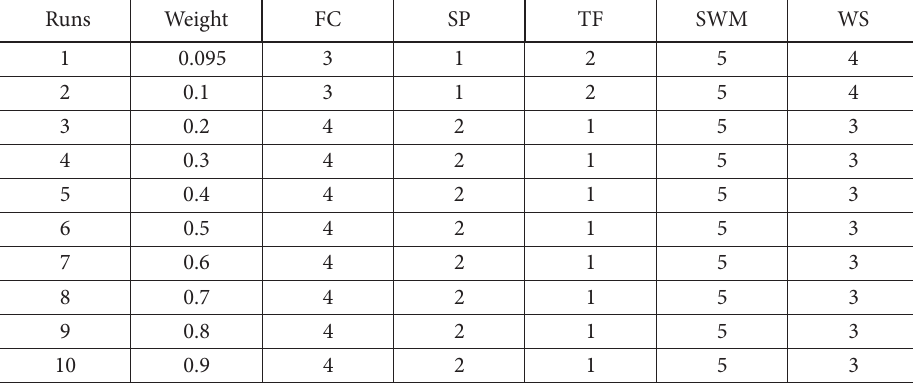
Table 11. Analysis of the Sensitivity of Projects under various criteria